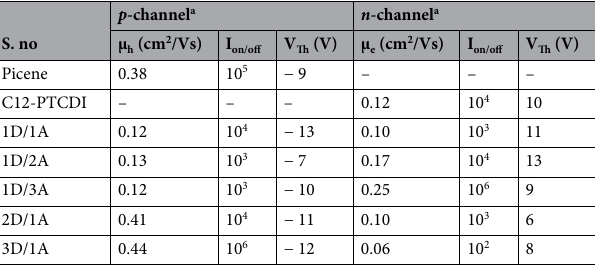
Table 3. OFET characteristics of D, A and D/A blends*. a Mean values of five devices.